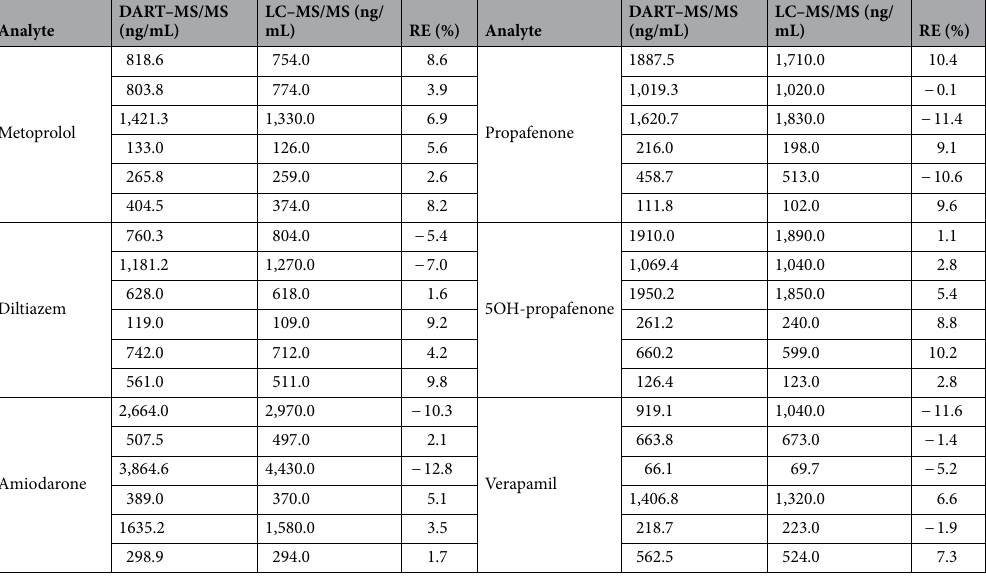
Table 6. The concentration of anti-arrhythmic compounds in 30 serum samples by DART–MS/MS and LC–